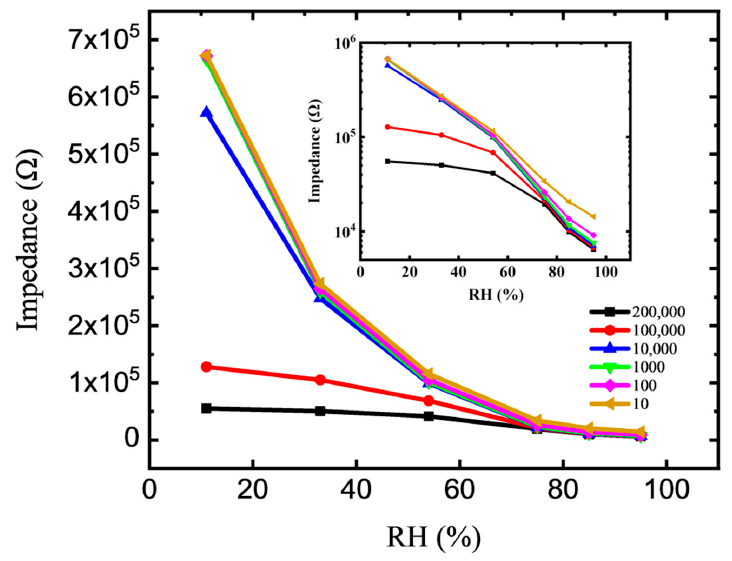
Figure 3. Impedance versus RH properties of the GO-based sensor. The insert is the impedance–RH curves displayed in logarithmic coordinates.